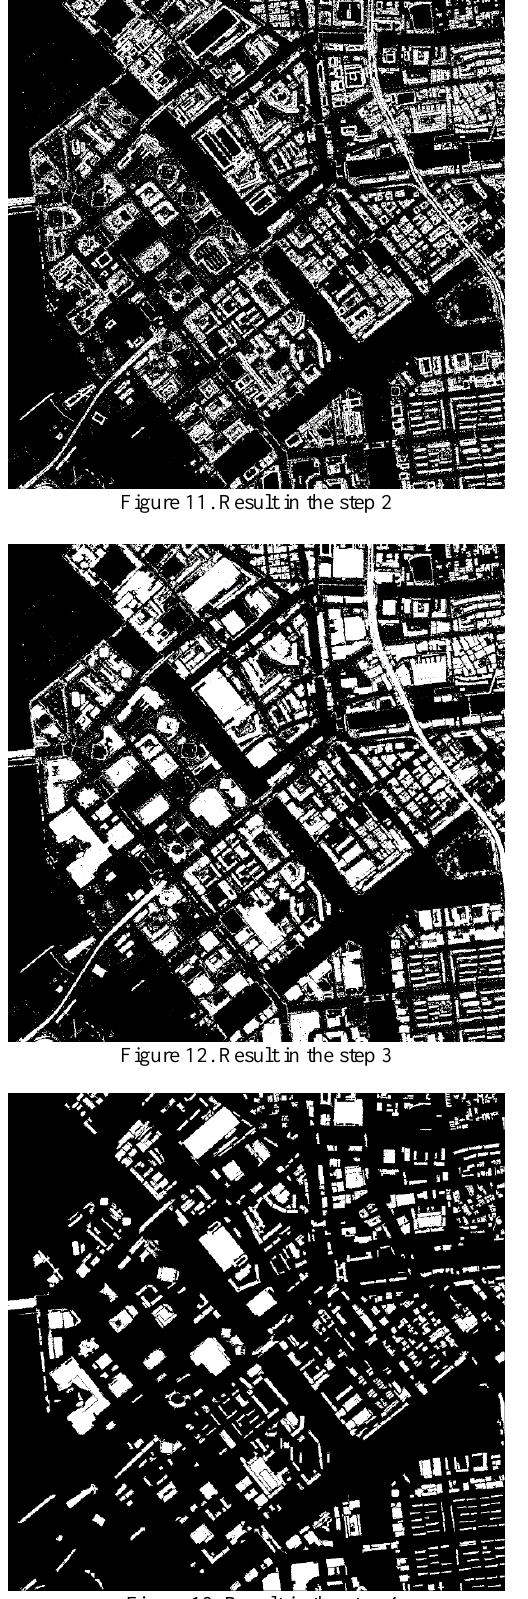
Figure 13. Result in the step 4